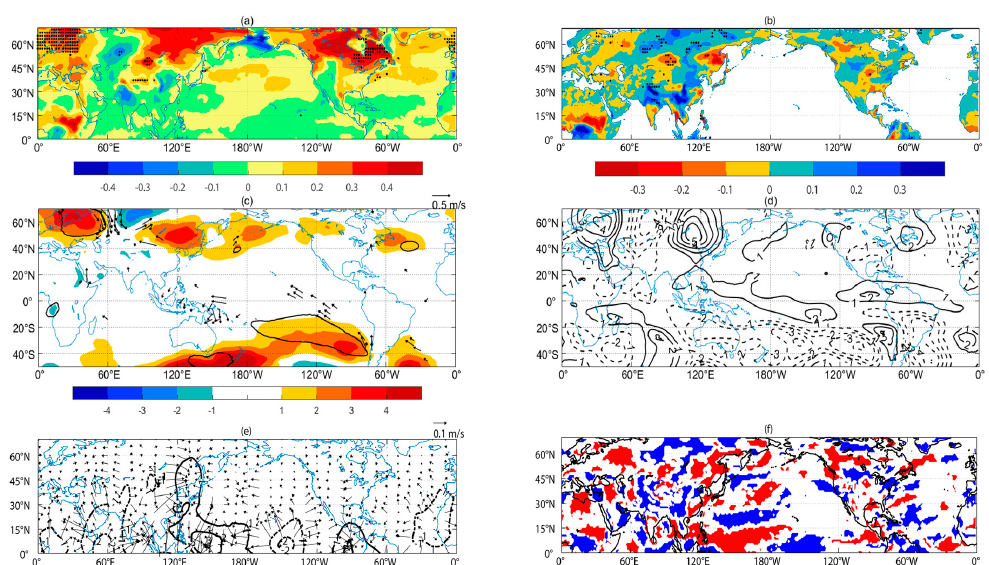
Figure 5. Regressions of the austral winter. ( a ) 2-meter air temperature ( ◦ C), ( b ) rainfall (mm/day), ( c ) geopotential height (gpm) and wind (m/s) at 850 hPa, ( d ) streamfunction (10 5 m 2 /s) at 500 hPa, ( e ) velocity potential (contours, unit: 10 5 m 2 /s) and divergent wind (vectors, unit: m/s) at 200 hPa, and ( f ) vertical velocity at 500 hPa (Pa/s) onto the SPIMV index. ( a , b ): Values exceeding 90% for the significance test are dotted. ( c ): Winds exceed 90% for the significance test; the black contours indicate the geopotential height exceeding 90% for the significance test. ( f ): Red shadings indicate descending motion and blue shadings indicate ascending motion.